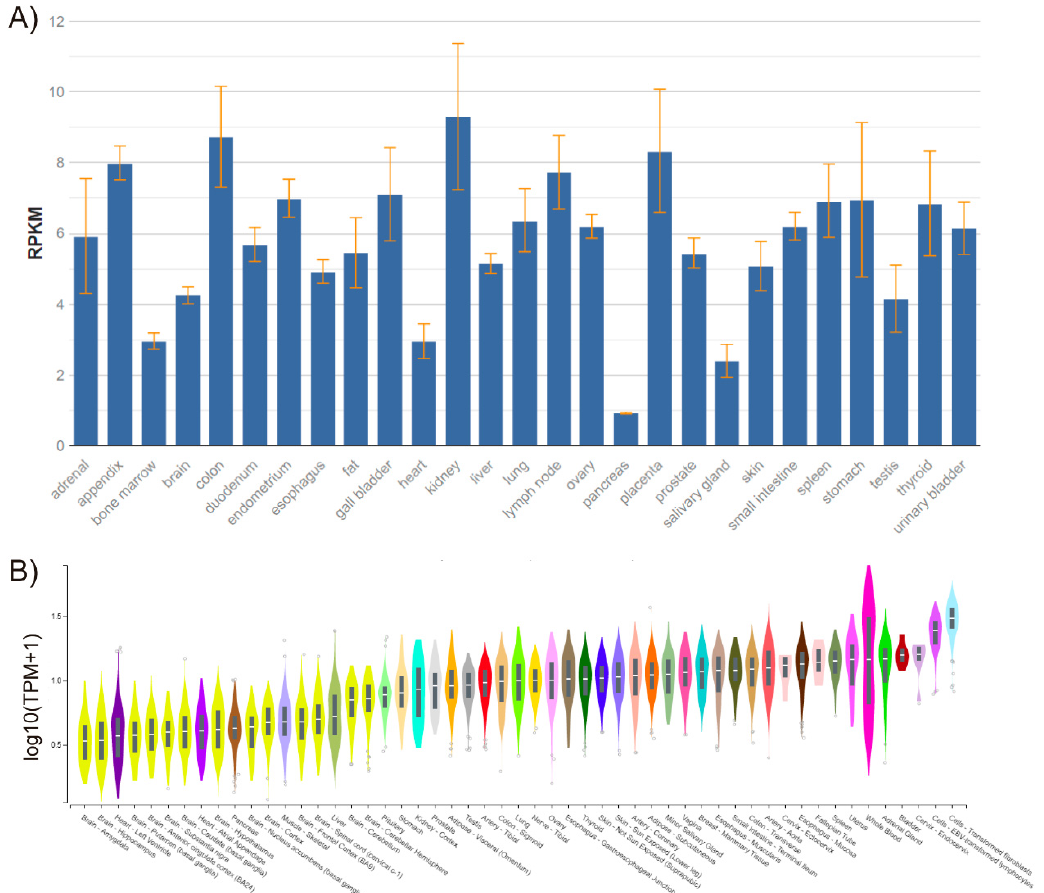
Figure 1. FADD expression in healthy human tissues, performed by RNA sequencing. ( A ) Data obtained from BioProject PRJEB4337 of samples from 95 individuals representing 27 different healthy tissues [3]. RPKM, Reads Per Kilobase Million. ( B ) Data obtained from GTEx Analysis Release V7 (dbGaP Accession phs000424.v7.p2). Expression values are shown in transcripts per million (TPM), calculated from a gene model with isoforms collapsed to a single gene and no other normalization steps applied. Box plots are shown as median and 25th and 75th percentiles; points are displayed as outliers if they are above or below 1.5 times the interquartile range.